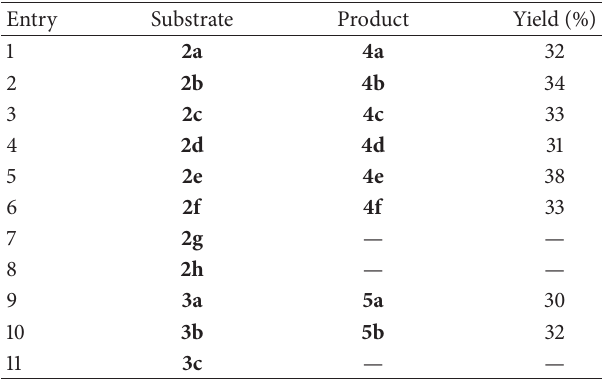
Table 1: Results of Schmidt reaction of E -3-benzylidenechroma- nones ( 2 ) and E -3-benzylidenethiochromanones ( 4 ) with NaN SO -HOAc. H 2 4